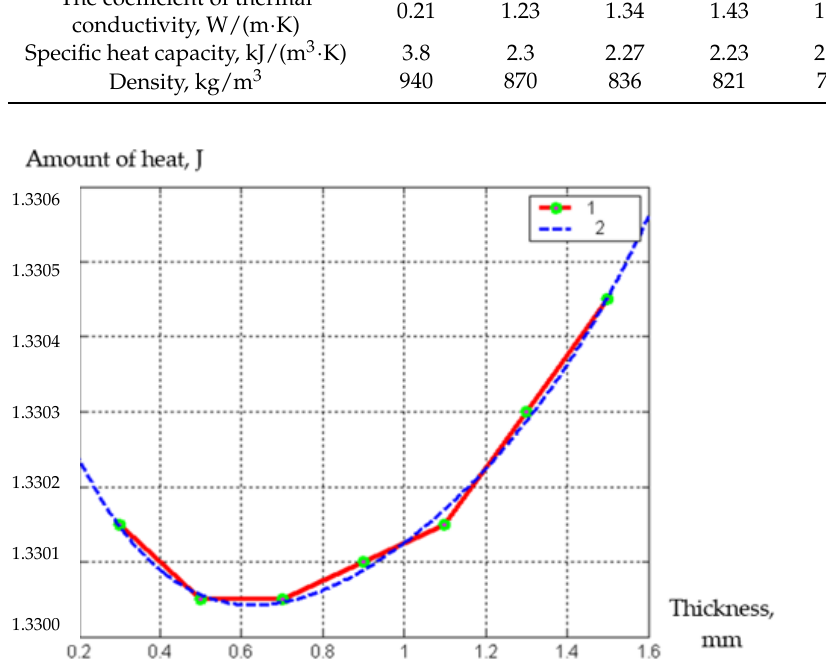
Figure 4. Dependence of the thickness (mm) of the frozen layer on the amount of heat (J) removed during preliminary freezing, 1—experimental curve, 2—approximating curve.